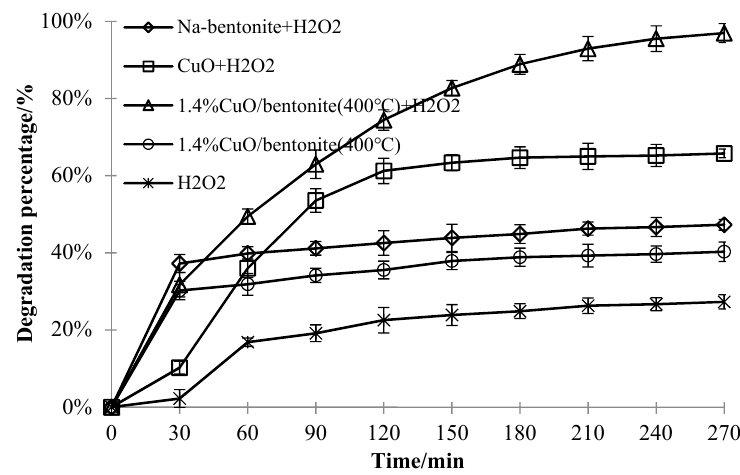
Figure 8. Effect of different catalysts on MB degradation performance.